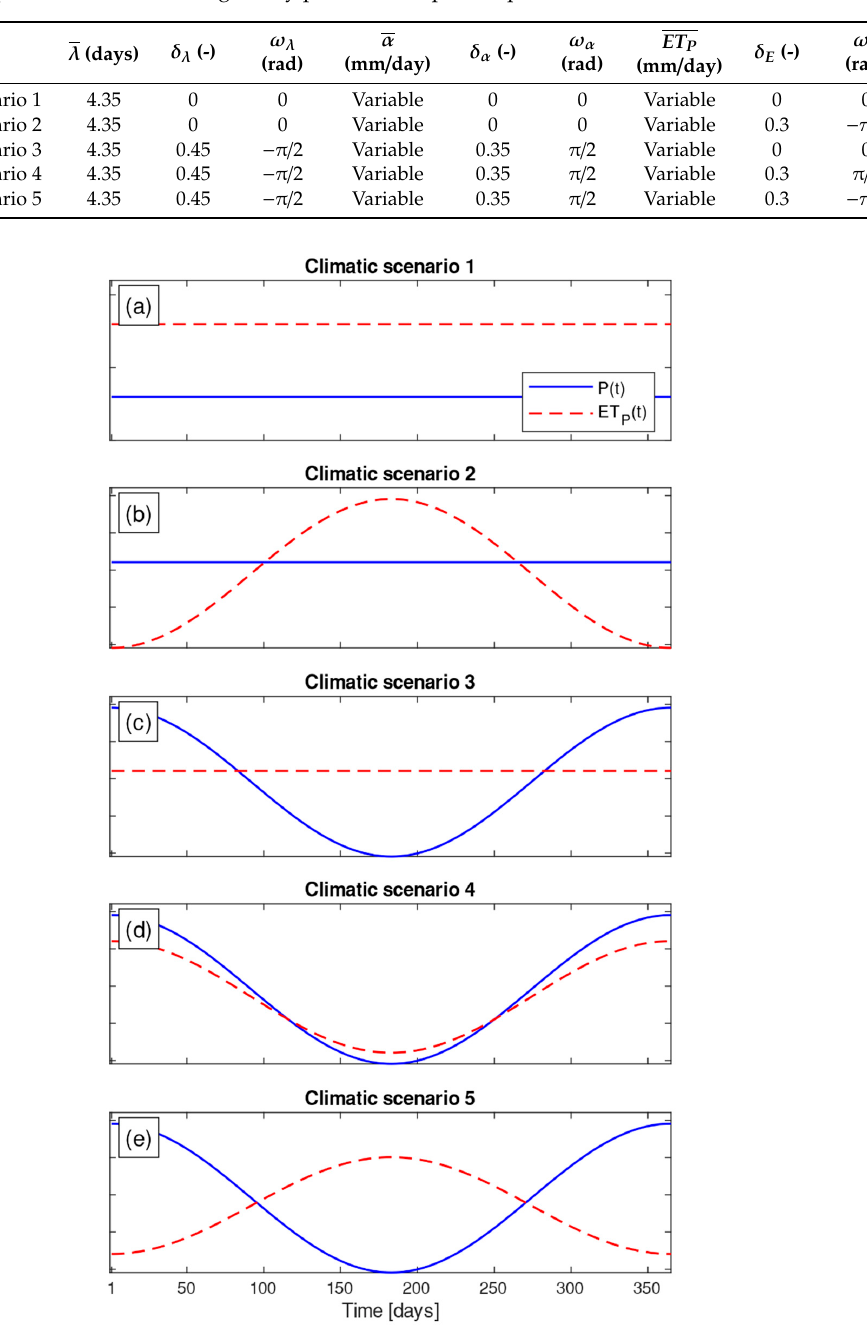
Figure 2. Schematic representation of seasonal time patterns of precipitation and potential evapotranspiration. Lines represent the daily mean of stochastic time series, as generated by Equations. 2 and 3 for 𝑃(𝑡) and by Equation. 4 as regard to 𝐸𝑇 (cid:3017) (𝑡) . Parameters are given in Table 1. Following Viola, Hellies, and Deidda [37].